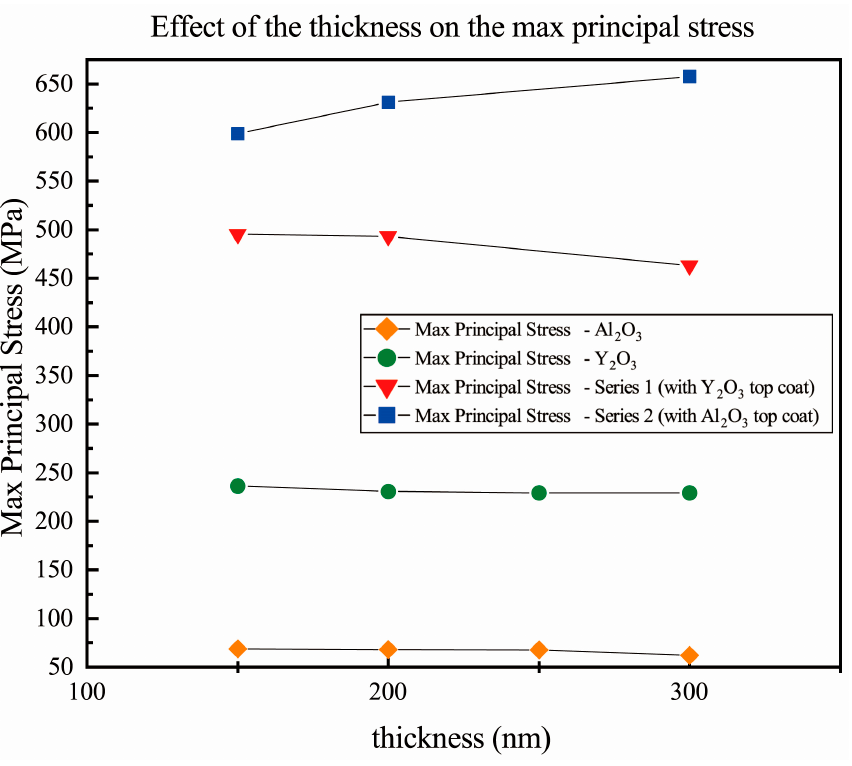
Figure 5. Effect of the thickness on the max principal stress of laminated coating and the correspond- ing monolayer